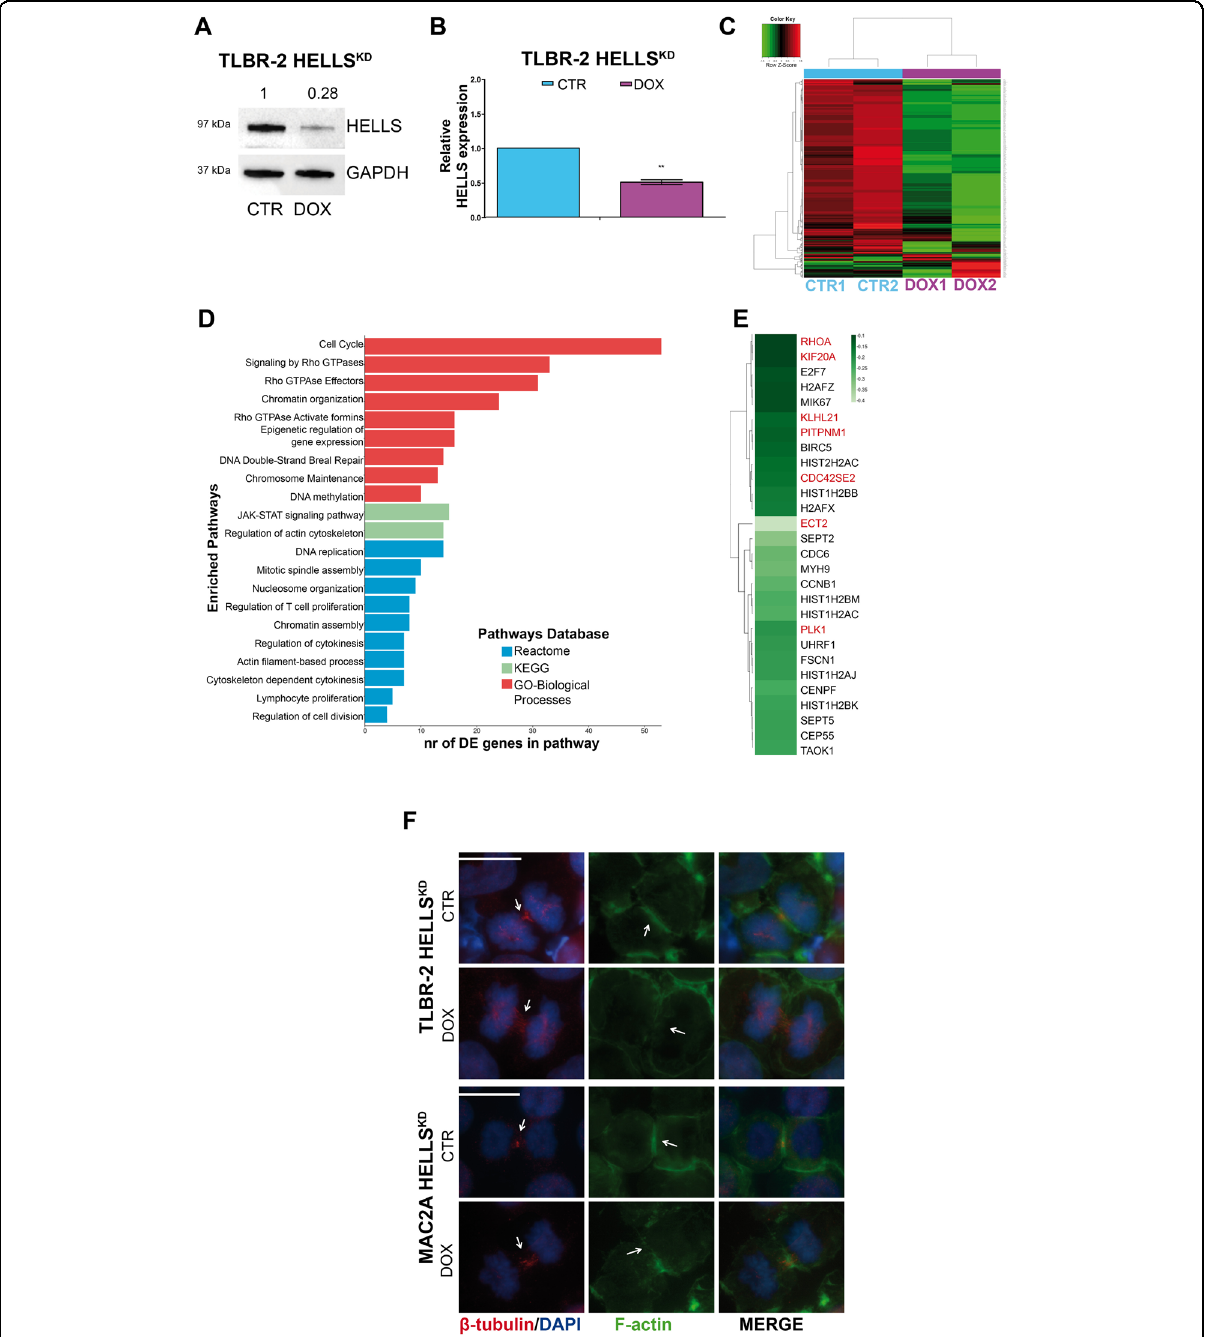
Fig. 1 HELLS transcriptionally controls cytokinesis. A Western blot shows HELLS expression in TLBR-2 HELLS KD cells after 48 h of doxycycline (DOX) induction. GAPDH was used as housekeeping gene. B qRT-PCR analysis of HELLS expression in TLBR-2 HELLS KD cells after 48 h of doxycycline induction. The values represent mean ± SEM ( n = 3) * p < 0.05; ** p < 0.01. C The heatmap depicts hierarchical clustering based on the 728 differentially expressed genes, whose read counts are Z-score normalized. Unsupervised hierarchical clustering was performed between DOX and CTRL samples (as indicated by the colored bar on columns) with a complete linkage method. Color intensity for each gene shows Z-score values ranging from red for upregulation and green for downregulation D Most signi fi cant enriched pathways (adjusted p-value<0.05) are represented showing the number of DE genes mapped in each considered pathway. E The heatmap depicts validated signi fi cantly downregulated genes. Green color bar shows fold difference on Log 2 scale calculated between DOX and CTRL samples. Darker green represents the most downregulated genes. Genes in red were selected for further validations. F Immuno fl uorescence images of TLBR-2 HELLS KD cells and MAC2A HELLS KD cells after 48 h of doxycycline (DOX) induction. Cells were stained with DAPI, F-actin, and β -tubulin antibodies. The white scale bar represents 10 μ